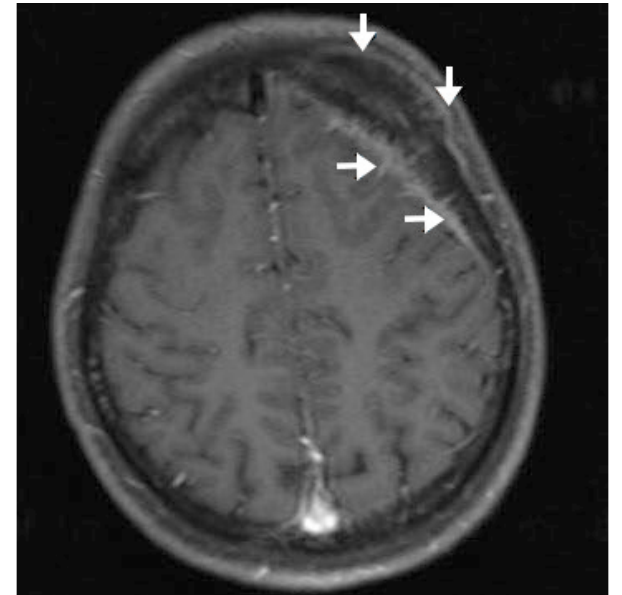
Fig. 4. Axial T1-weighted MR image post gadolinium contrast administration shows a bony lesion measuring approximately 7 cm x 7.2 cm x 2 cm in size with minimal homogenous contrast enhancement. However, the underlying dura demonstrates an intense